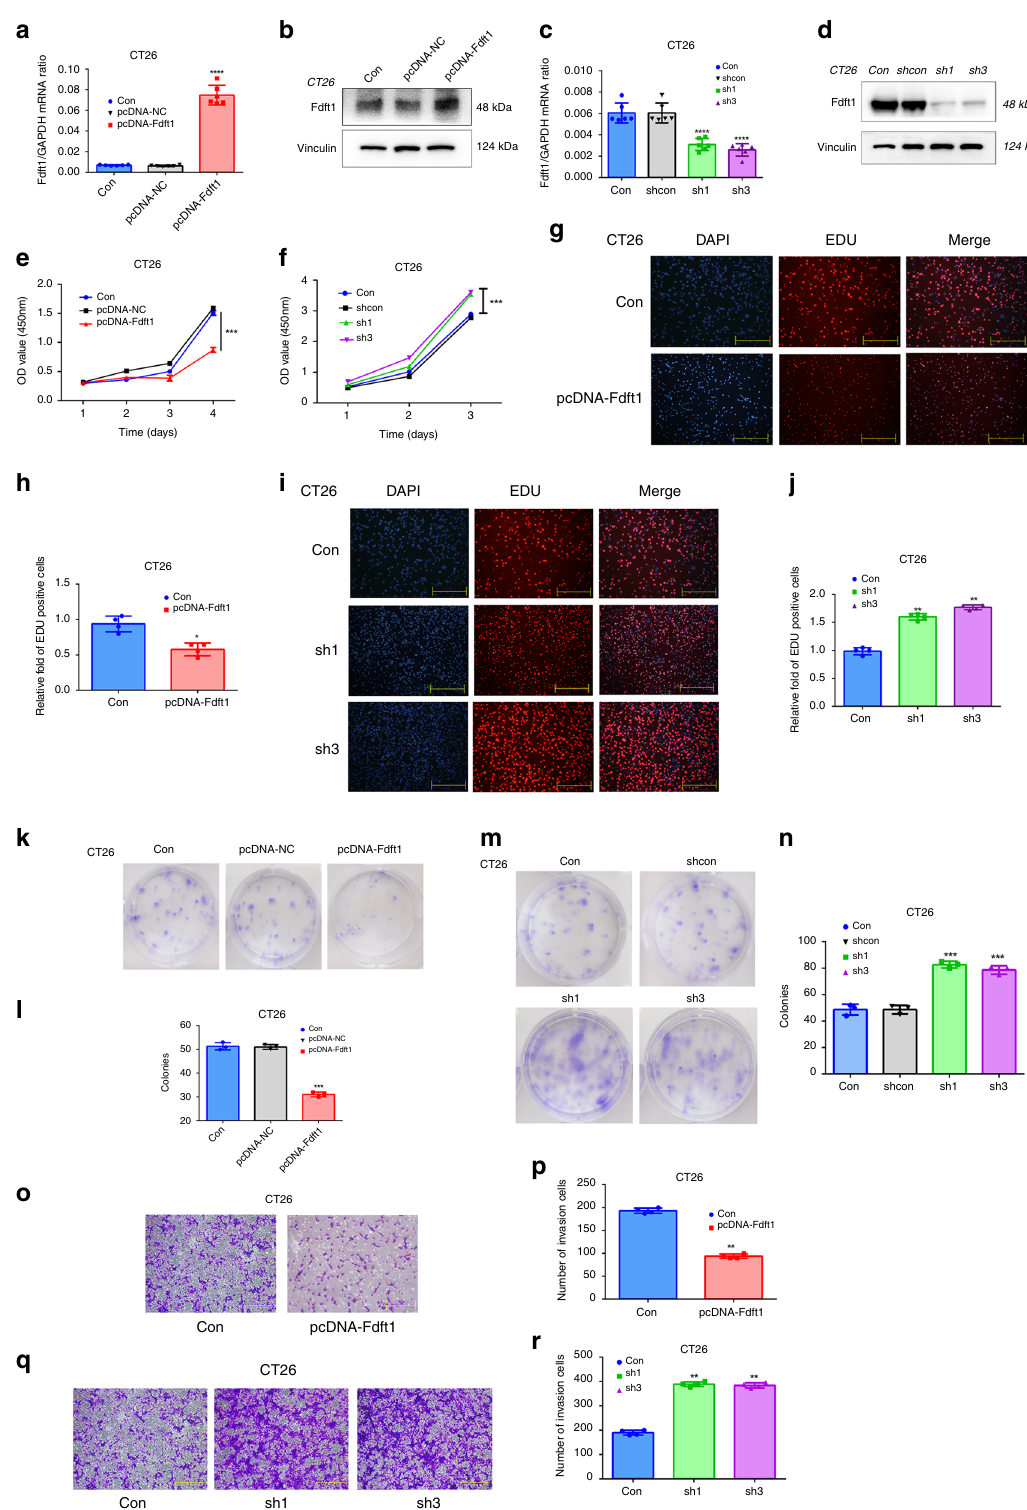
subcutaneously injected CT26 cells and FDFT1 -overexpressing CT26 cells into BALB/c mice. Our results indicated that both the FMD and FDFT1 overexpression inhibited tumor growth in the mice. Compared with FMD alone or FDFT1 - overexpressing alone, FMD combined with FDFT1 overexpres- sing had the most dramatic inhibitory effect on tumor growth in the mice (Fig. 4c, d). Consistent with these results,